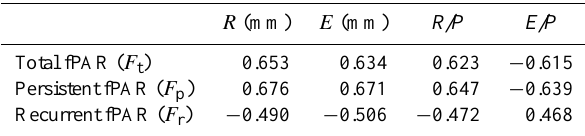
Table 2. Correlation coefficients between vegetation cover and runoff components (including surface runoff, subsurface runoff and their ratios to total runoff) over the 193 study